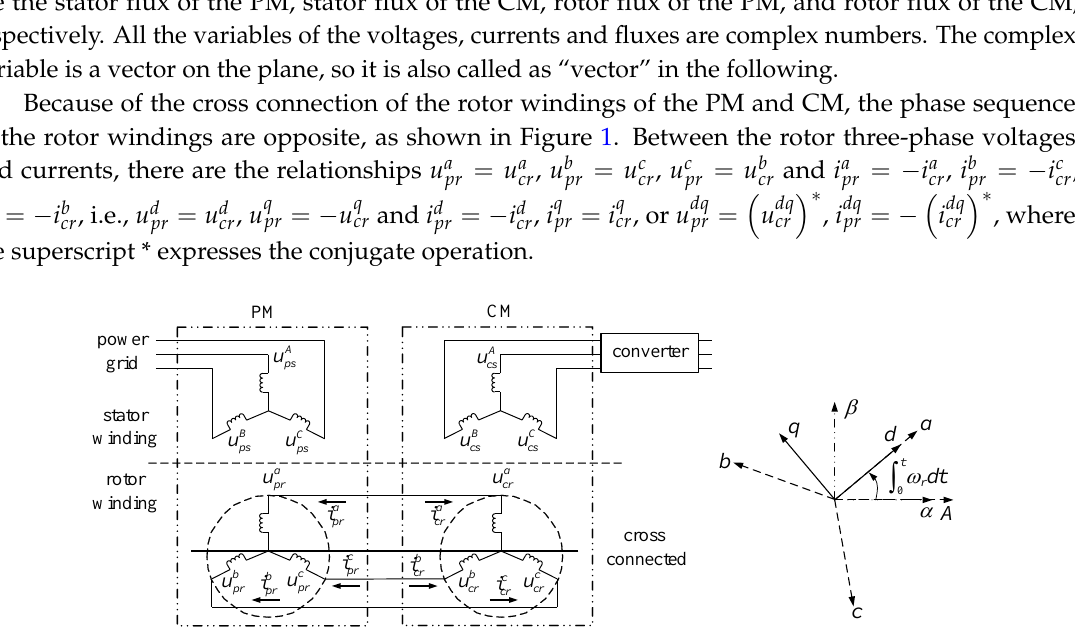
Figure 1. Variables of stator and rotor windings, stator ABC reference frame, static αβ reference frame, rotor abc reference frame and rotor dq reference frame.